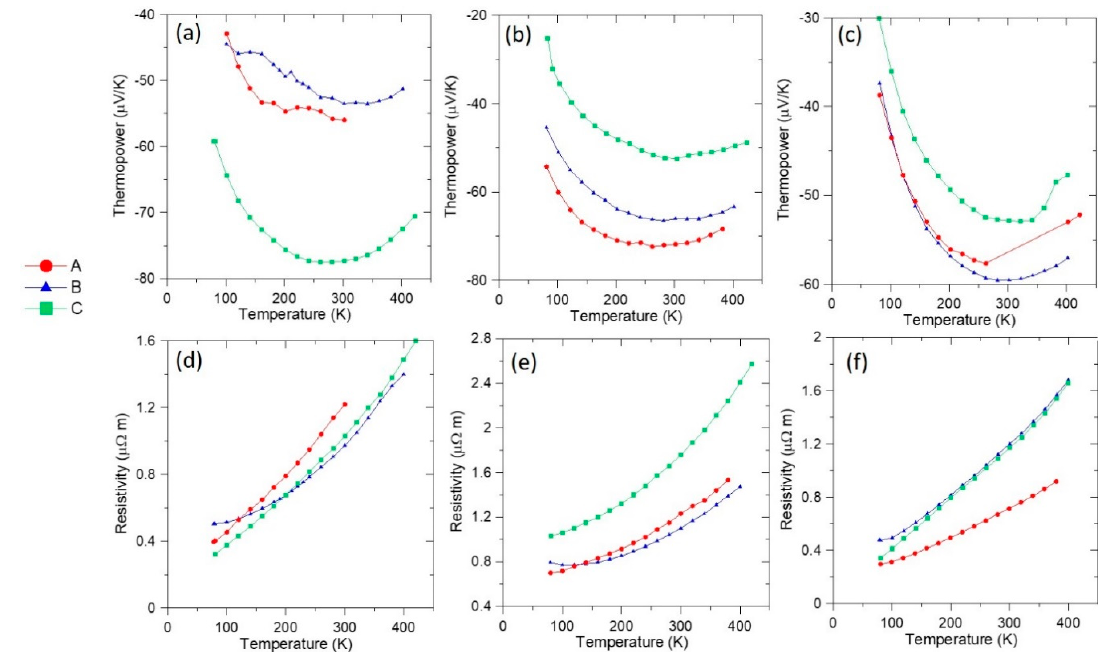
Figure 7. The top row shows temperature dependence of the thermopower of samples in each configuration (see Figure 6) with the following compositions: ( a ) 2 at.% MnBi; ( b ) 10 at.% MnBi; ( c ) 35 at.% MnBi. The bottom row shows resistivity versus temperature of samples in each configuration with the following compositions: ( d ) 2 at.% MnBi; ( e ) 10 at.% MnBi; ( f ) 35 at.% MnBi. Nanomaterials 2020 , 10 , x FOR PEER REVIEW